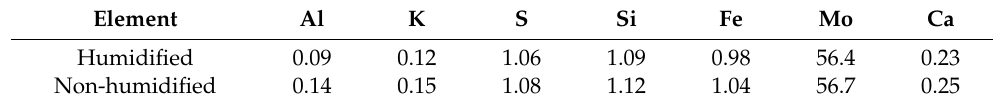
Table 4. Effect of humidification on the content of impurity elements in washed molybdenum calcine/%. Element